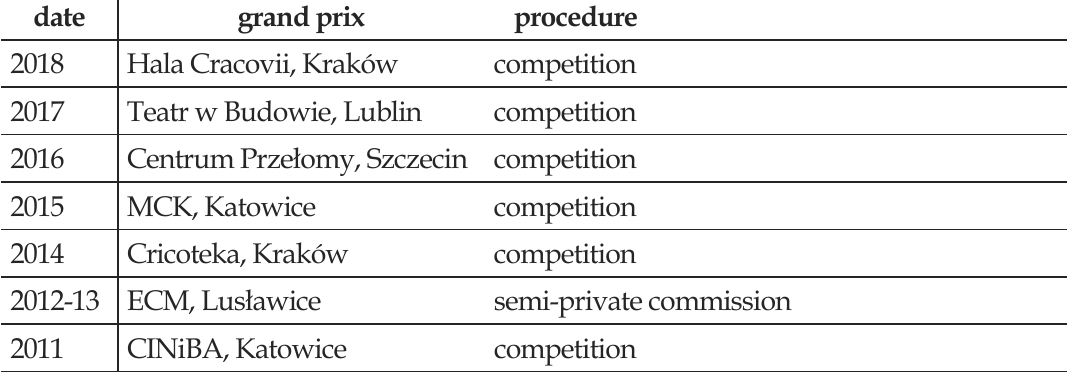
SARP Award of the Year – grand